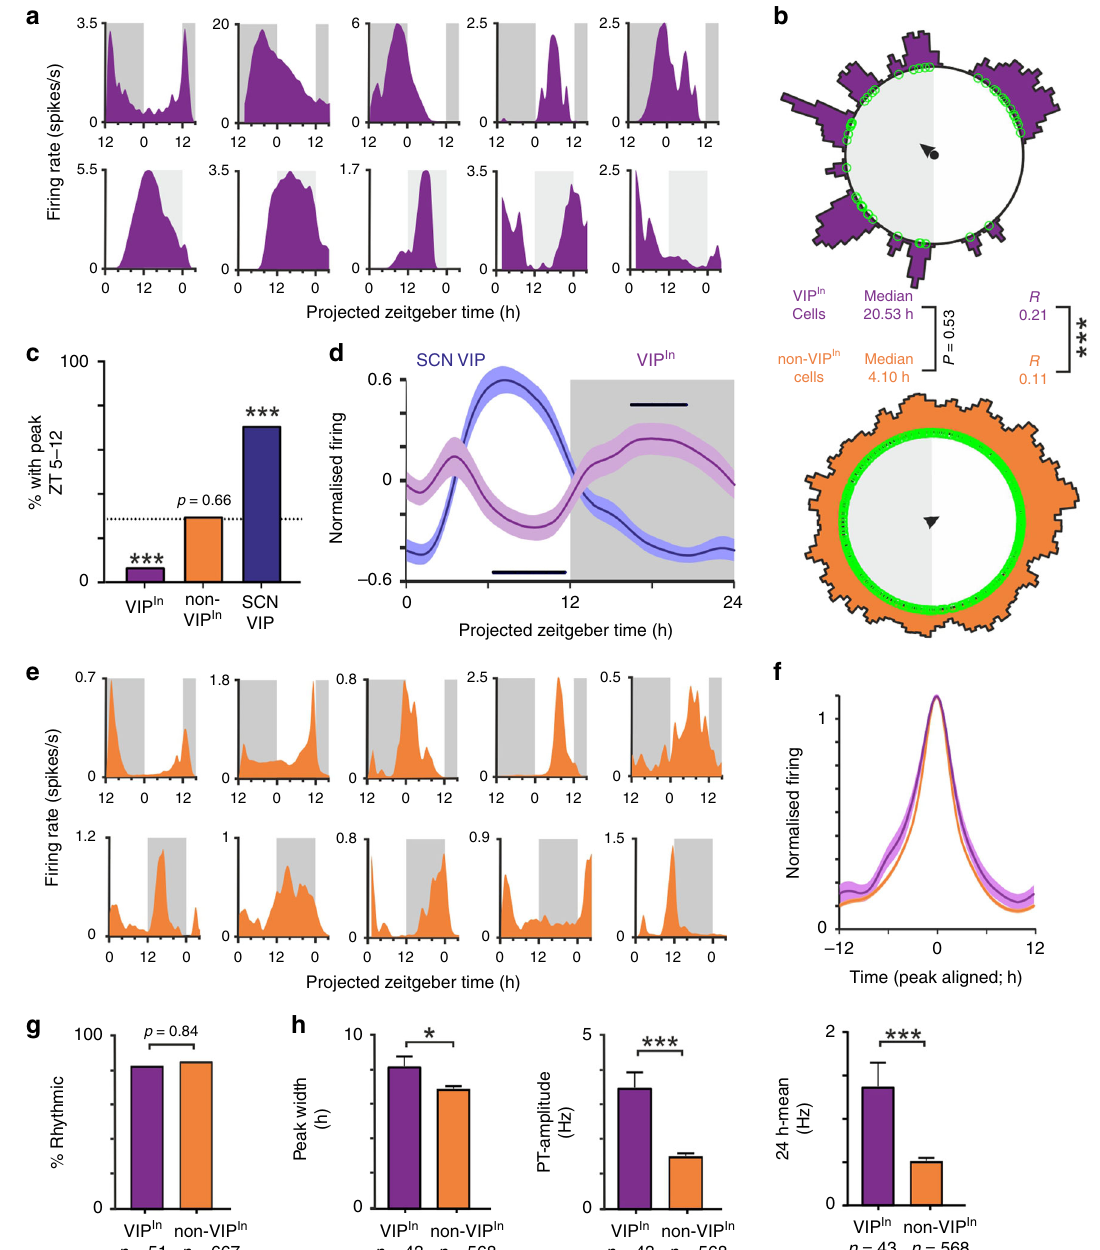
Fig. 3 VIP in cells exhibit robust daily variations in electrophysiological output. a , e Example spontaneous fi ring activity from optogenetically identi fi ed VIP in ( a ) and non-VIP in cells ( e ), from slices prepared during late (top panels) or early (bottom panels) projected day. b Rayleigh plots showing phase distribution for isolated VIP in and non-VIP in cells that exhibited evidence of circadian variation in fi ring ( n = 43 and 567 cells, from 22 late and 23 early day slices, respectively). Conventions and analysis as in Fig. 1e. c Proportion of VIP in , non-VIP in and SCN VIP cells with peak fi ring between projected ZT5-12, dotted line represents proportion expected by chance, data analysed by Fisher's exact test. d Mean ± SEM normalised, ZT aligned, 24 h fi ring pro fi les of rhythmic VIP in and SCN VIP neurons. Black bars indicate when VIP in activity is signi fi cantly different from the daily mean. Data analysed by one-way RM ANOVA (F 3.169, 133.1 = 3.42, P = 0.02) with post-hoc one-sample t -tests ( P > 0.05). f Mean ± SEM normalised, peak aligned, 24 h fi ring pro fi les of rhythmic VIP in and non-VIP in neurons. g Proportion of isolated VIP in and non-VIP in cells d i splaying evidence of circadian variation in fi ring, proportions compared by Fisher's exact test. h Peak width, Peak-trough amplitude (middle) and 24 h mean fi ring rate (right) for rhythmic VIP in and non-VIP in cells. Data compared by multilevel mixed-effects linear model. * P < 0.05, *** P <